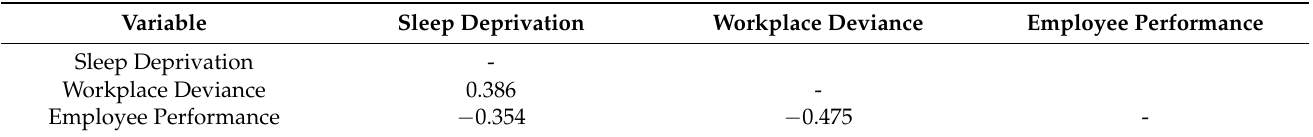
Table 3. Correlation matrix.